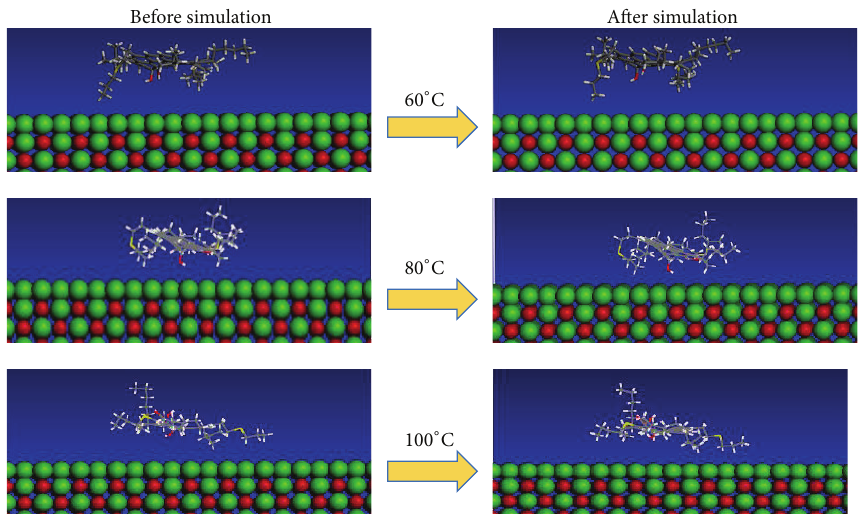
Figure 11: The interface configuration of asphaltene/CaO (60–100 ∘ C).